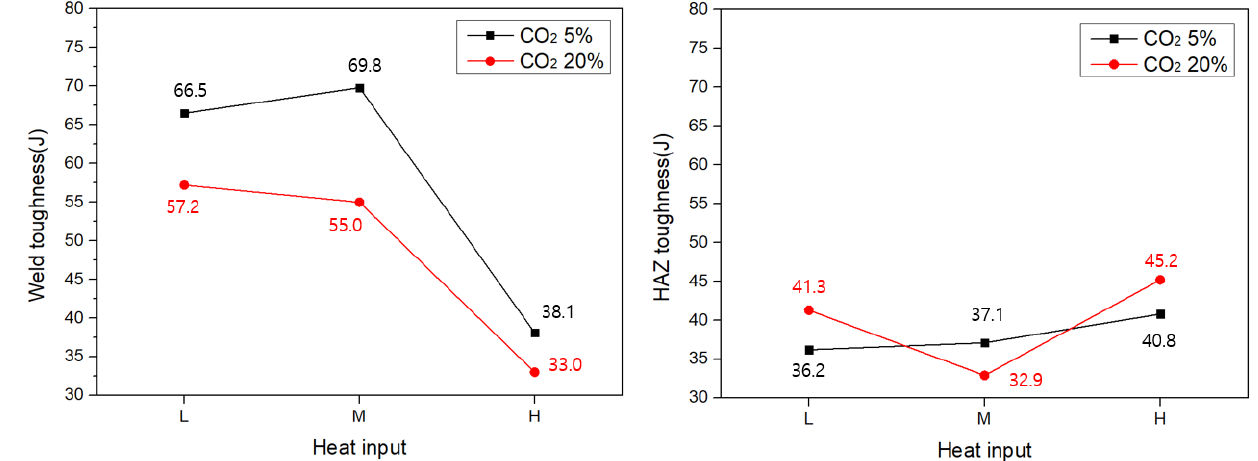
Figure 12. Toughness results of GMAW with CO 2 5% and 20% shielding gas and heat input at room temperature (20 °C).